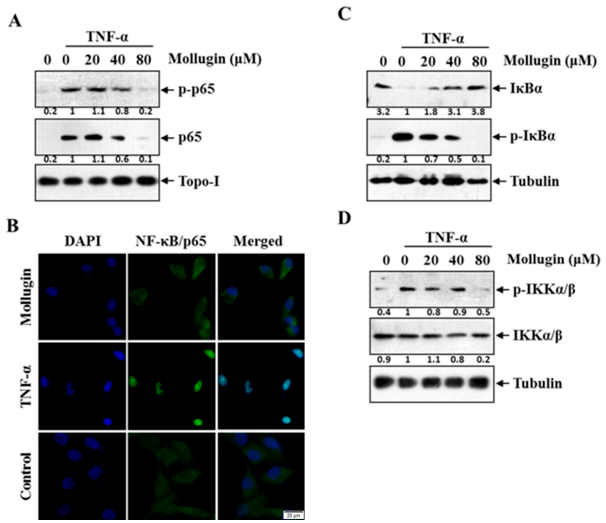
Figure 2. Mollugin inhibits TNF- α -induced phosphorylation and nuclear translocation of p65, phosphorylation and degradation of I κ B α , and IKK phosphorylation. ( A ) HeLa cells were stimulated with 10 ng/mL TNF- α for 30 min after pretreatment of mollugin (20 µ M, 40 µ M, and 80 µ M) for 12